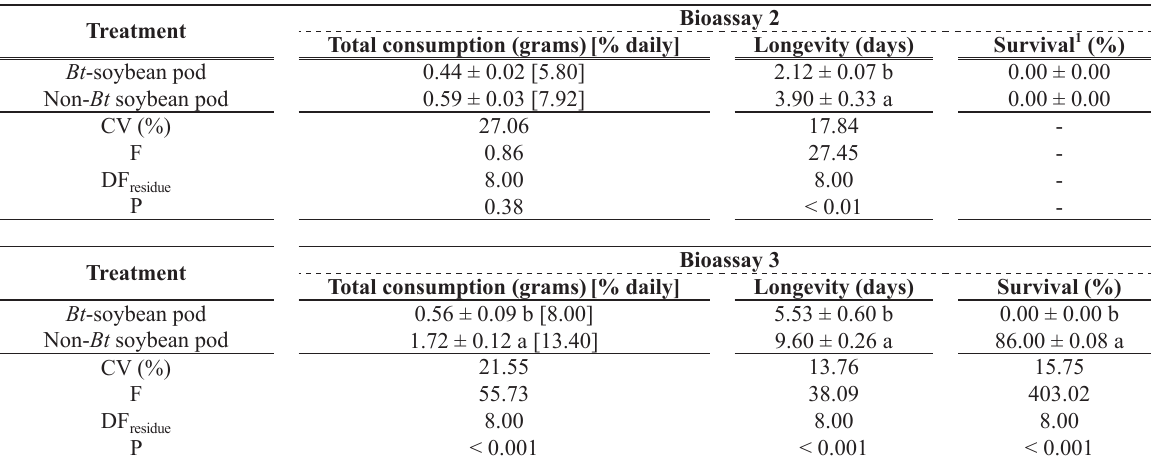
Biological aspects of Heliothis virescens fed with fresh Bt soybean pods and its isogenic non- Bt , from the third (bioassay 2) and fifth instar (bioassay 3) under controlled